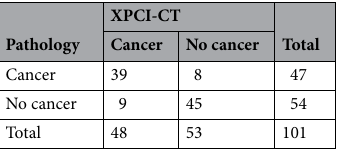
Table 1. 2 × 2 contingency table for cancer presence at margins as detected by XPCI-CT.